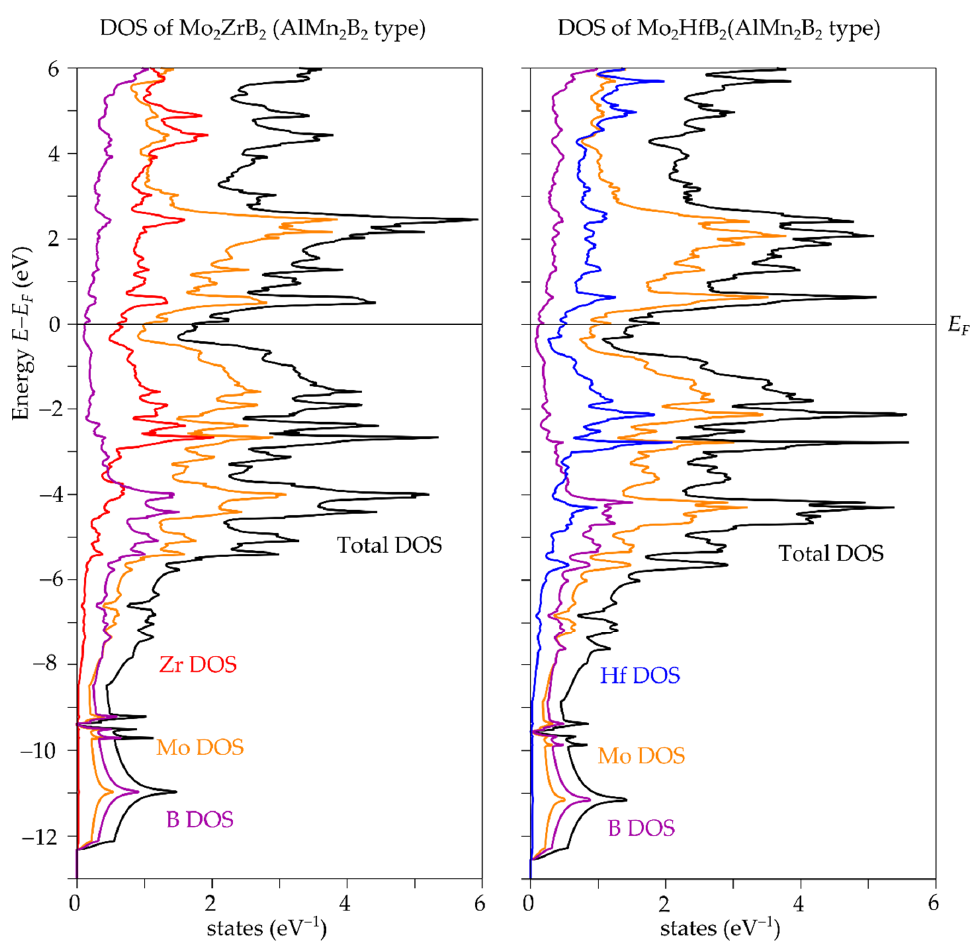
Figure 2. Electronic density of states (DOS) of Mo 2 ZrB 2 ( left ) and Mo2HfB2 ( right ) both with AlMn 2 B 2 -type structure.